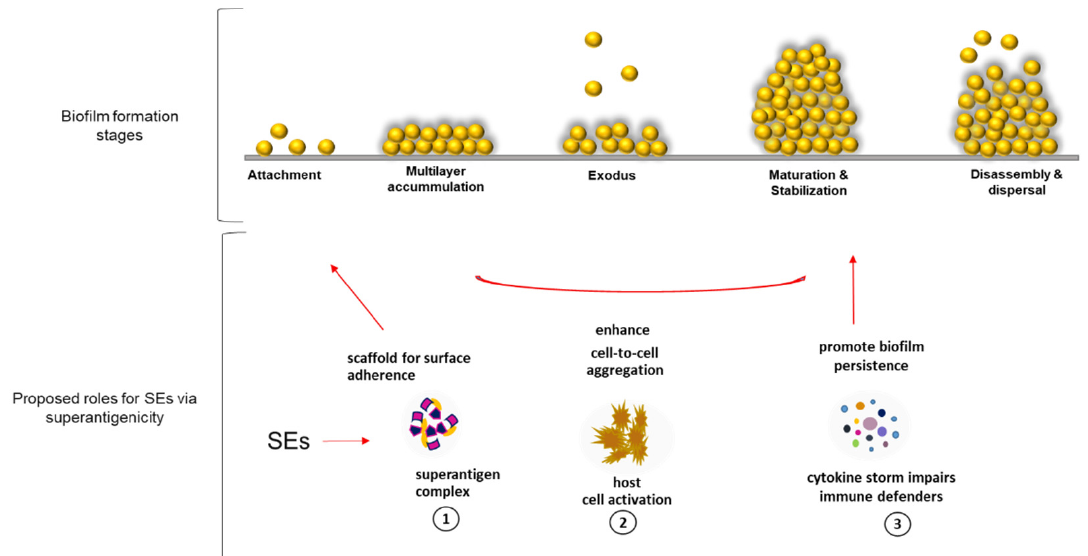
Figure 6. Proposed roles played by SEs via superantigenic activity in the developmental stages of S . aureus biofilm. (1) Superantigen complex formation provides a scaffold for matrix framework, (2) mediate cell-to-cell aggregation by activating platelet cells, which become sticky and adhere to each other, enhancing biofilm accumulation, and (3) modulate biofilm survival and persistence by